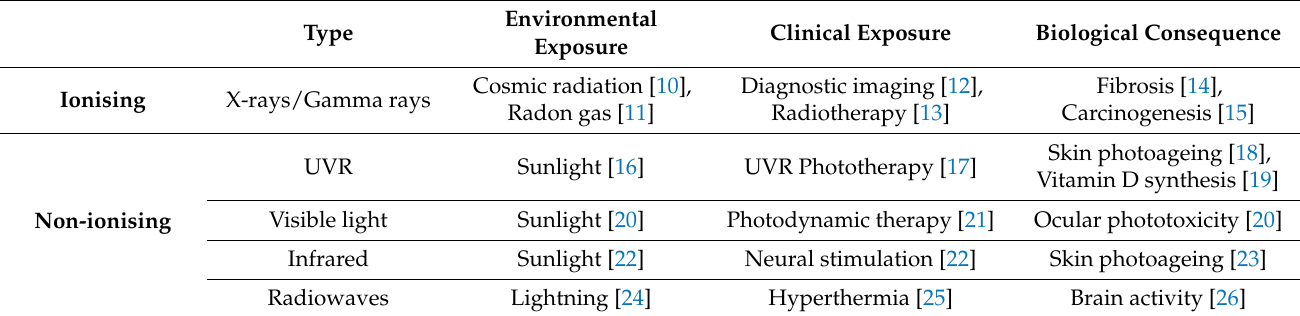
Table 1. Human exposure to ionising and non-ionising electromagnetic radiation can come from the environment or from clinical interventions. Exposure to both types of radiation can have clear clinical benefits but may also result in detrimental biological